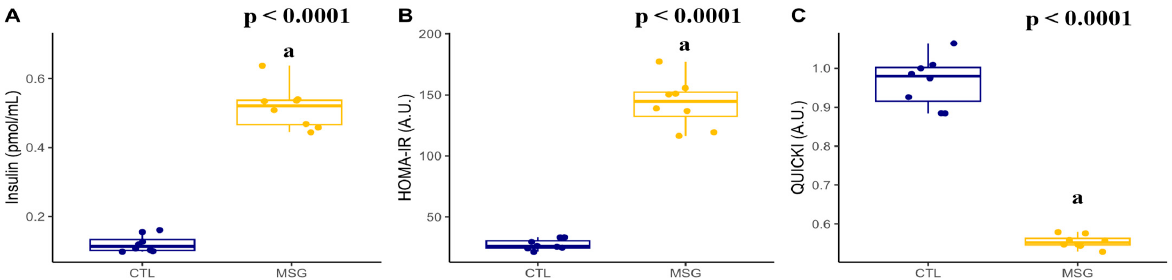
Figure 10. Graphs related to insulin plasmatic profile in PND142: ( A ): insulin ( µ IU/mL); ( B ): HOMA- R (A.U); ( C ): QUICKI (A.U). The CTL group is represented in blue and the MSG group is represented in yellow. The letter a represents the difference between the MSG group when compared to the CTL group. All data: Student’s t -test.